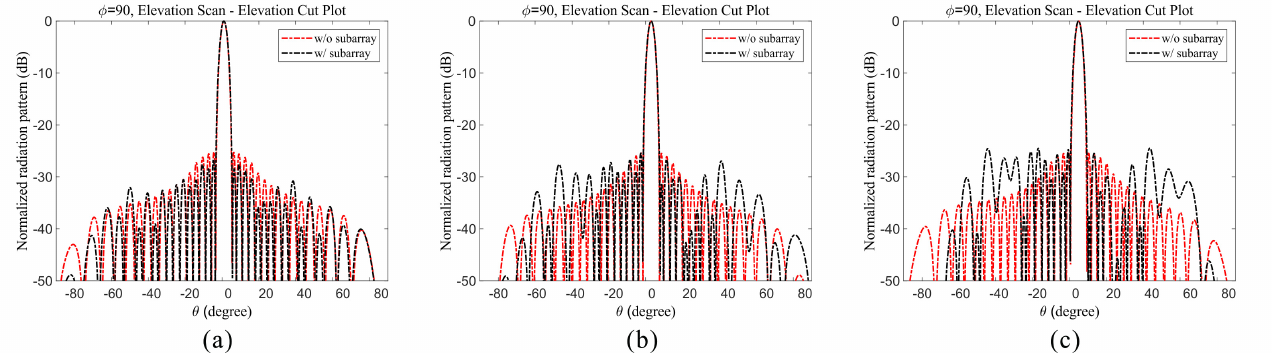
Figure 7. Radiation pattern when scanning the elevation at 30 GHz (w/a subarray (96 TRMs) vs. w/o a subarray (576 TRMs)): ( a ) 1 ◦ scanning, ( b ) 3 ◦ scanning and ( c ) 5 ◦